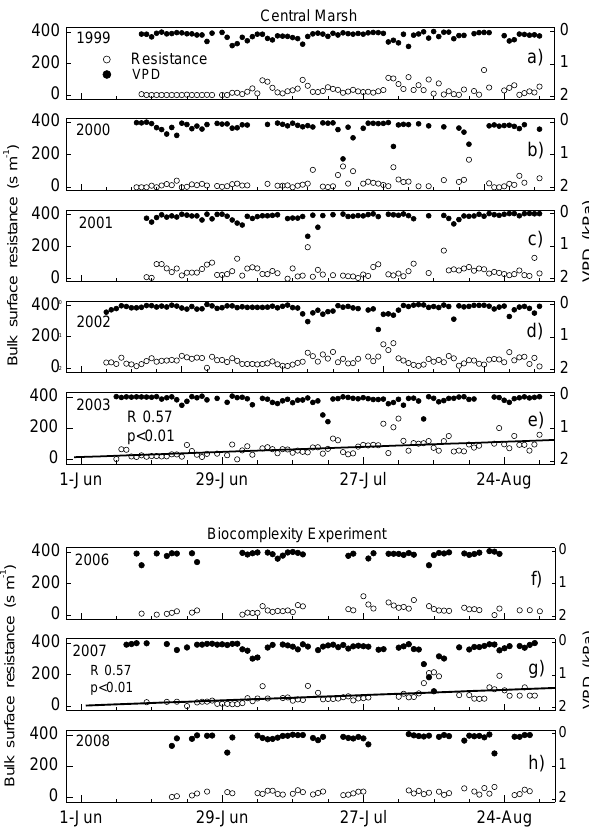
Fig. 6. Mean midday values of bulk surface resistance ( r c ) and VPD at the CM (a–e) and BE (f–h) sites.